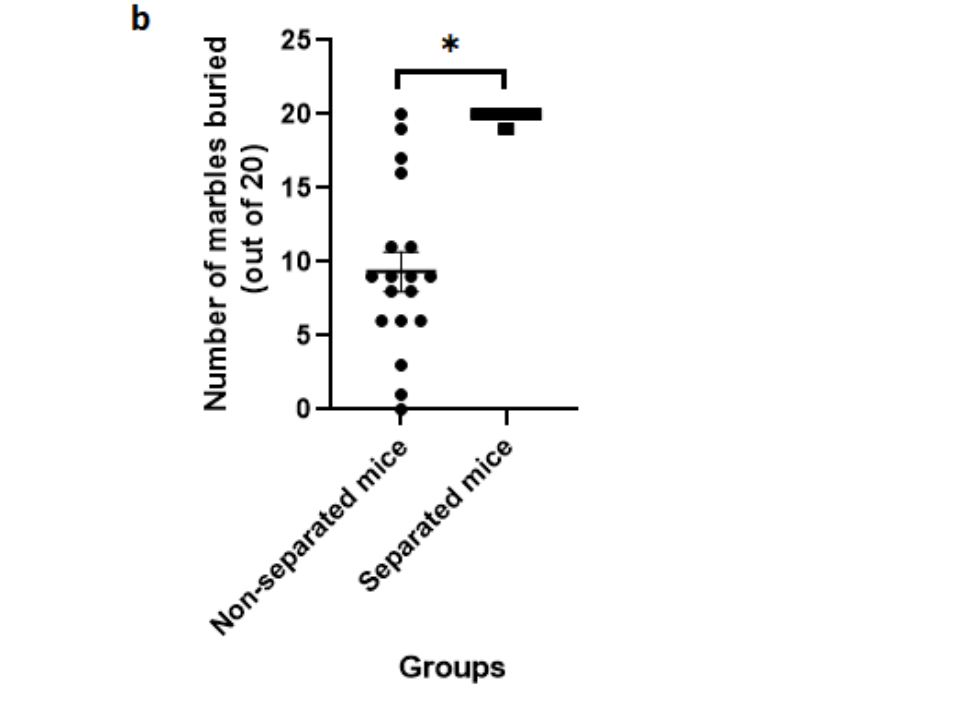
Figure 6. ( a ) Number of marbles buried at 15 min during MB test. ( b ) Number of marbles buried at 30 min during MB test. (*) indicates significant difference ( p < 0.05) between separated and non-separated mice by the unpaired t test ( n = 18/each group).